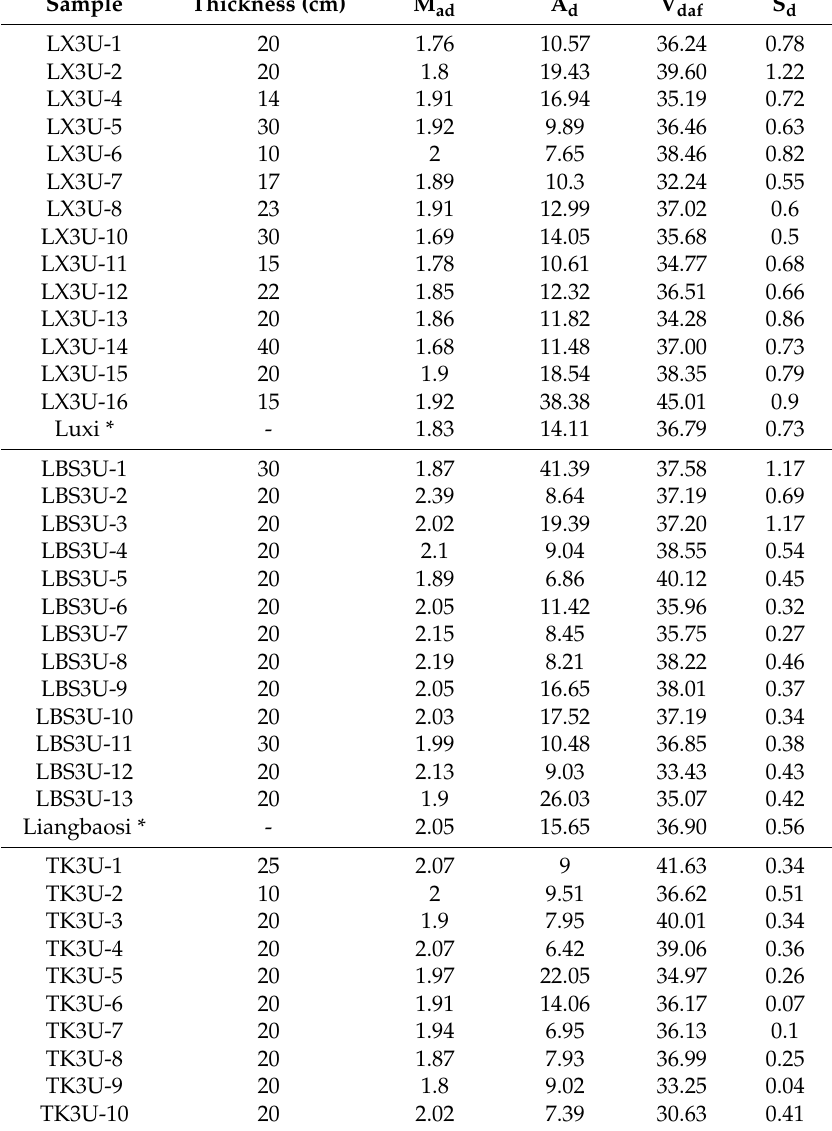
Table 1. Moisture, ash yield, volatile matter yield, and total sulfur content (%) in the Upper No. 3 coals from the Luxi, Liangbaosi, and Tangkou mines, southwestern Shandong,